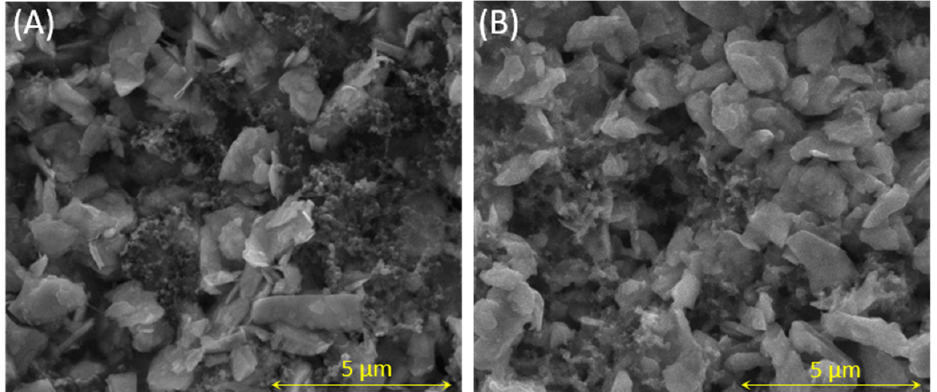
Figure 3. FESEM images at 10,000× of ( A ) fresh and ( B ) cycled MoS 2 -based electrodes.